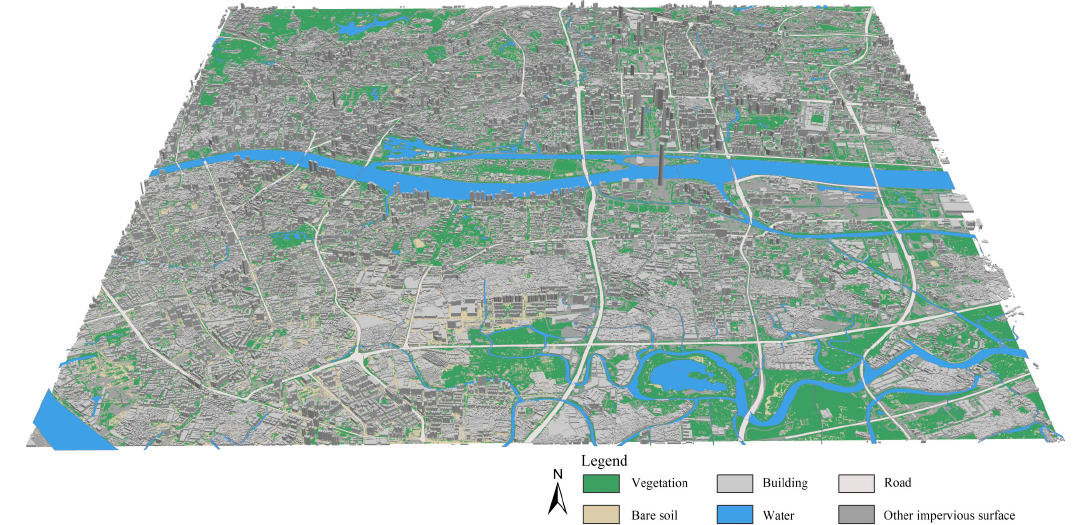
Figure 6. 3D land surface cover map for the central urbanized area of Guangzhou.